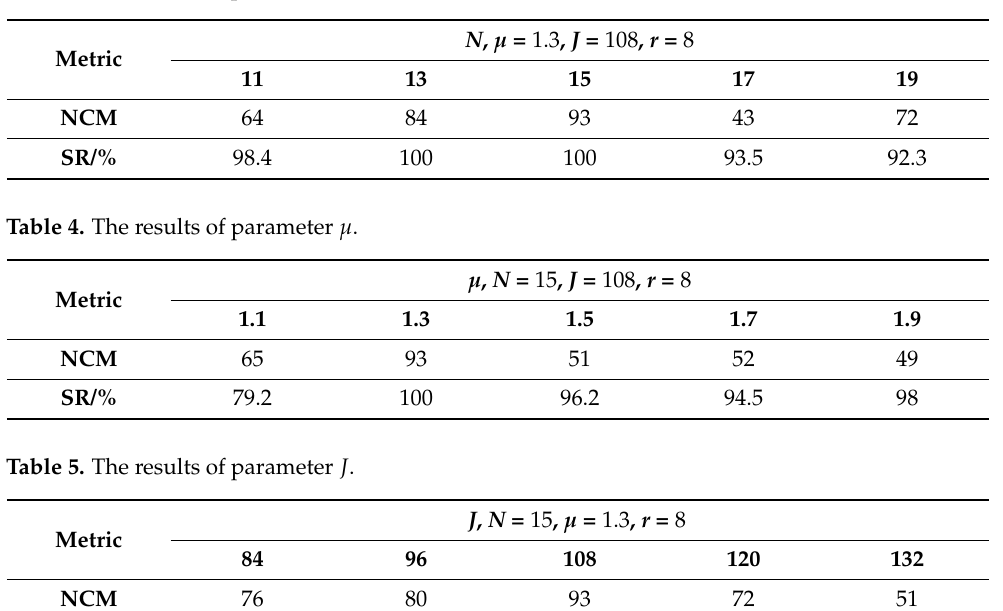
Table 3. The results of parameter N .